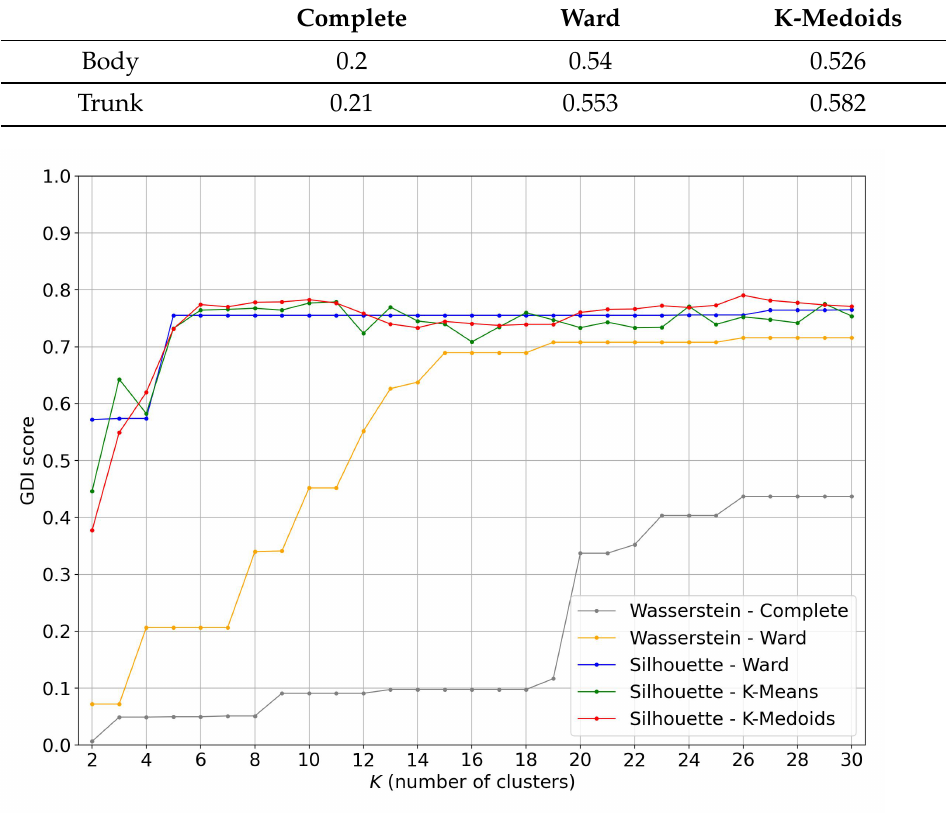
Figure 16. Comparison of GDI score on the persistence diagrams of the whole body and the trunk with the Wasserstein